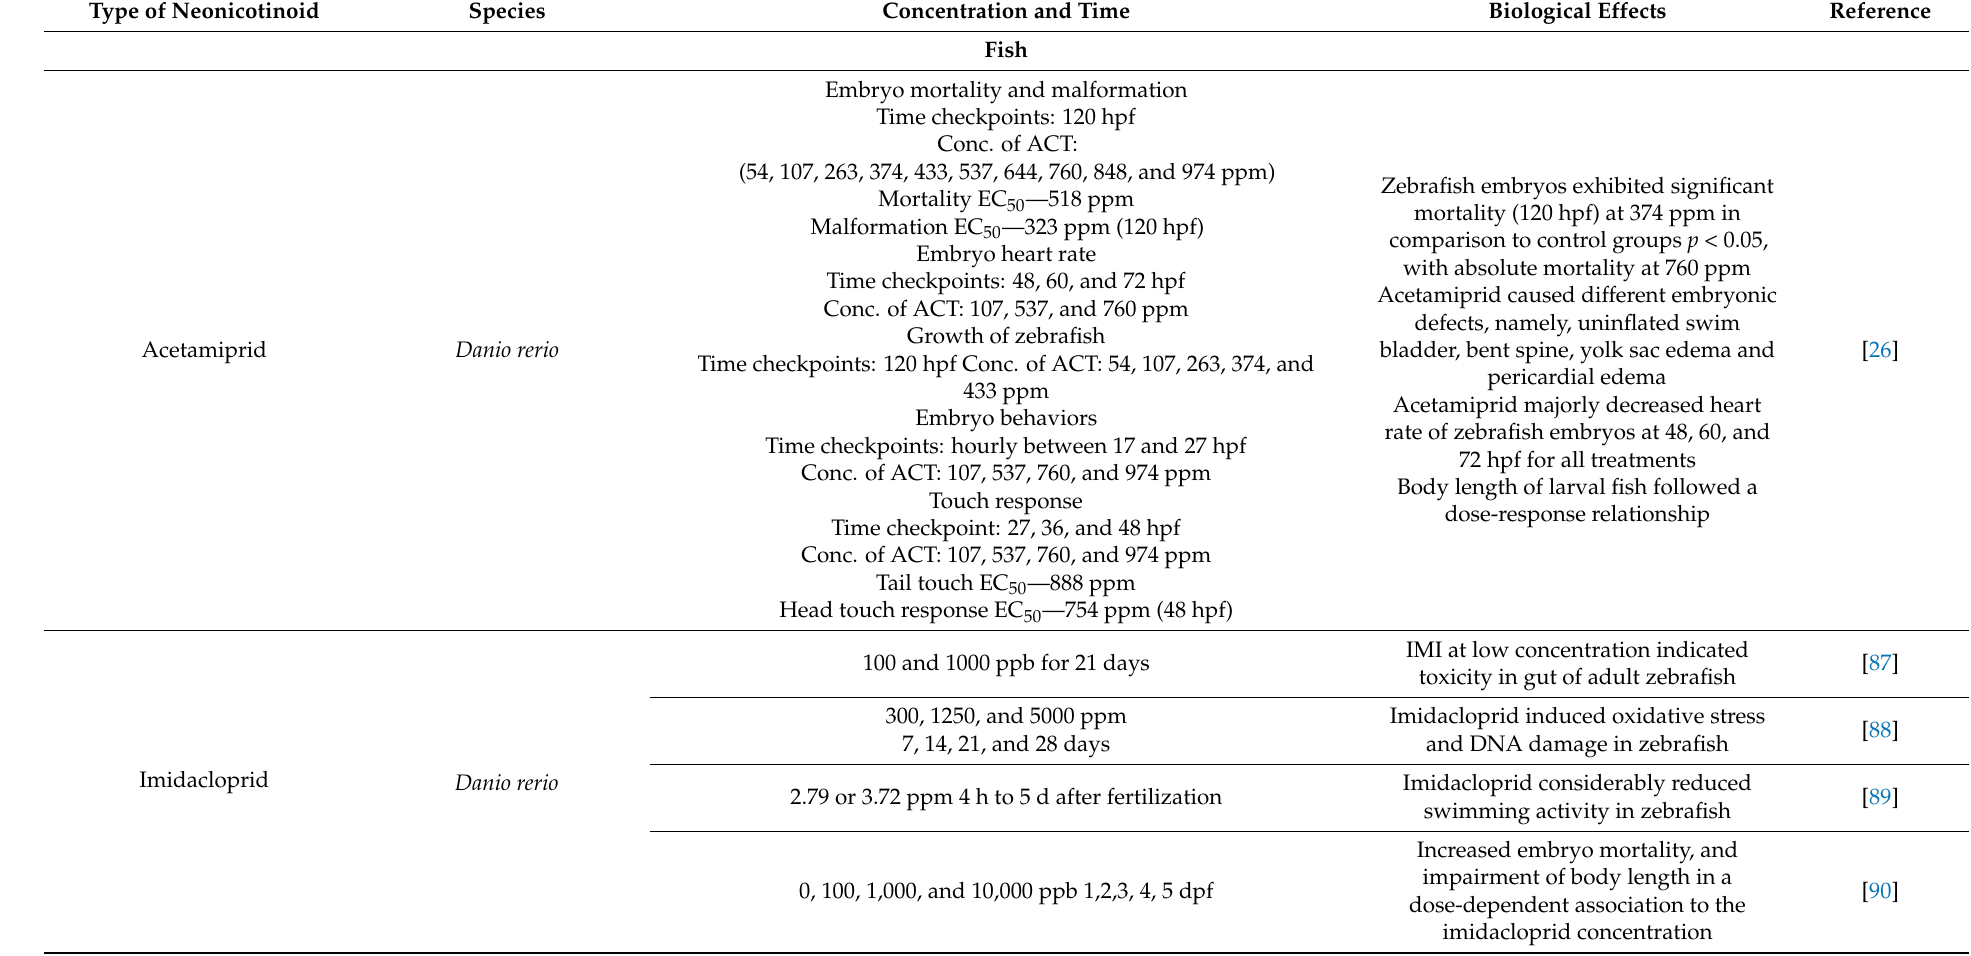
Table 2. The potential adverse effects of neonicotinoid insecticides on aquatic